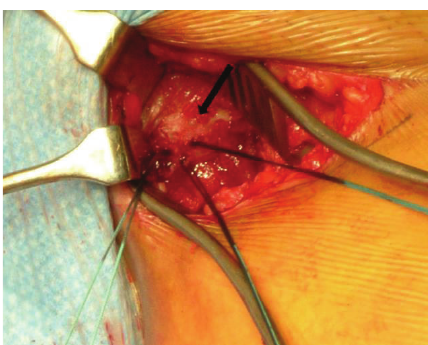
Figure 3: The avulsed adductor longus tendon end was reattached to the pubis (black arrow) with 3 suture bone